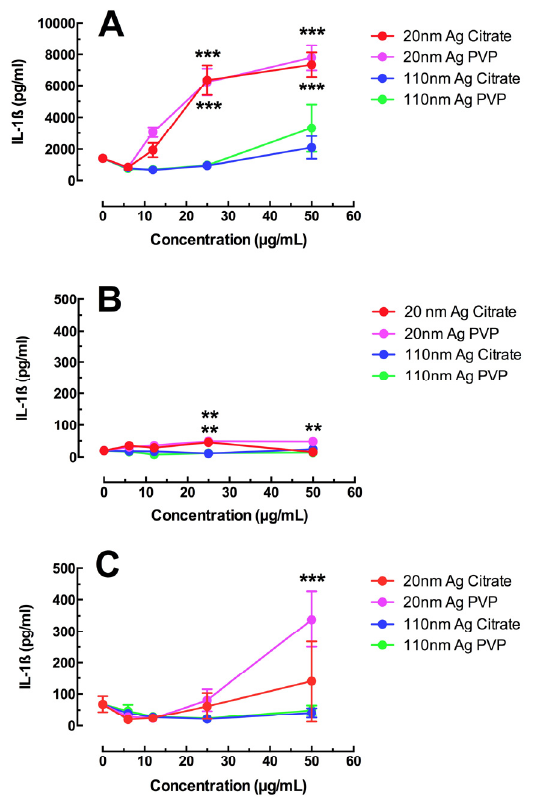
Figure 2. NLRP3 activation in three macrophage cell models using IL-1 β release as a proxy measure. ( A ) IL-1 β release from transformed THP-1 cells 24 h post Ag exposure; ( B ) IL-1 β release from C57BL/6 AM 24 h post Ag exposure; ( C ) IL-1 β release from MARCO null AM 24 h post Ag exposure. All data expressed as mean ± SEM. Asterisks indicate significance at *** p < 0.001, or ** p < 0.01, compared to 0 µg/mL control condition by post hoc mean